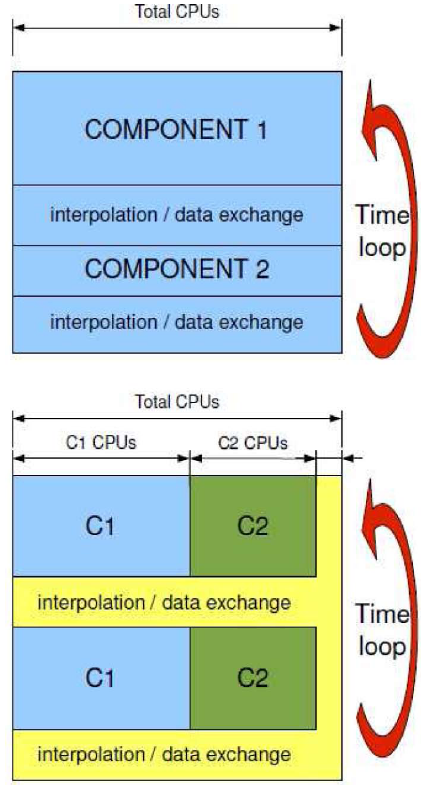
Fig. 1. Coupling methods between the different model components (C1 and C2) of an AO-GCM (upper panel “internal method”, as im- plemented here, lower panel ”external method” as used for example in the OASIS coupler). The colours denote the different executa-